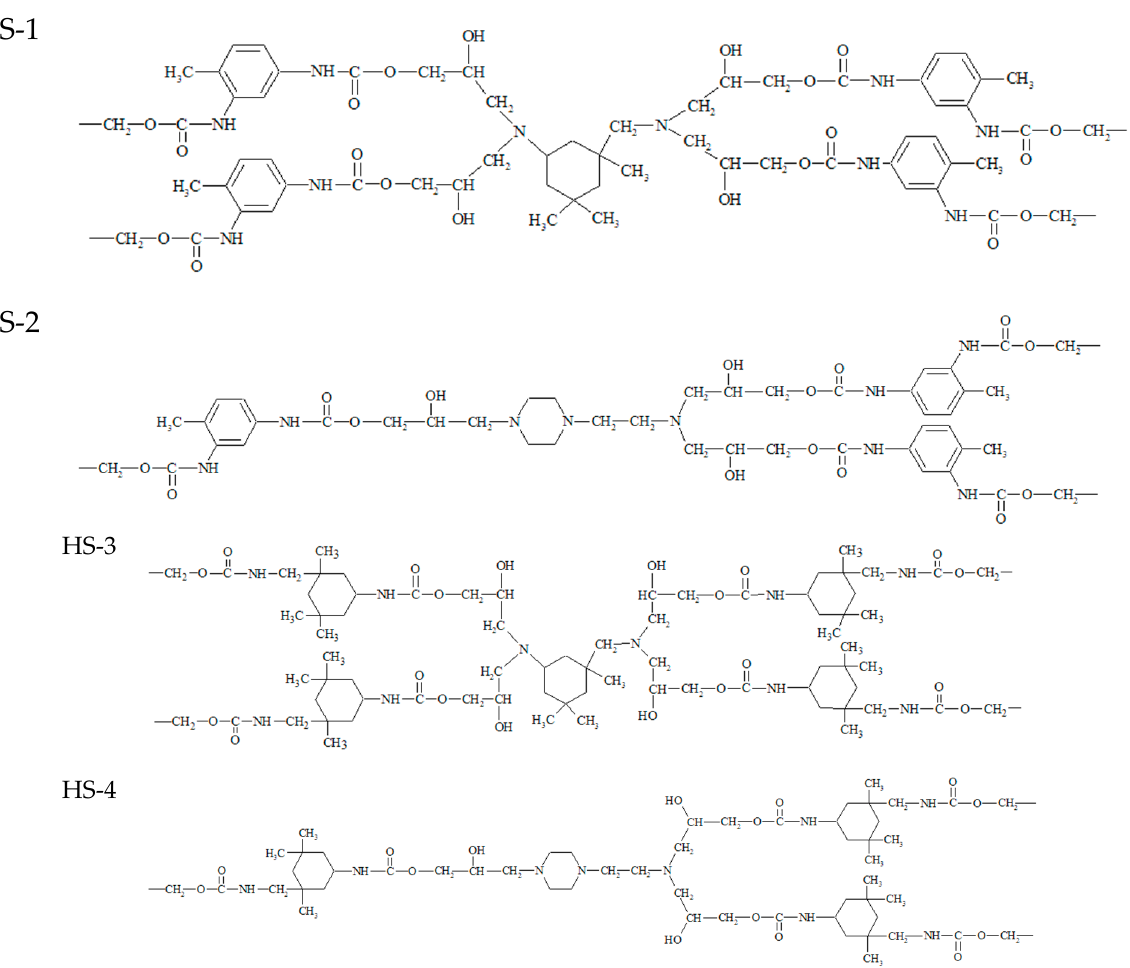
77.16 ppm for 13 C.